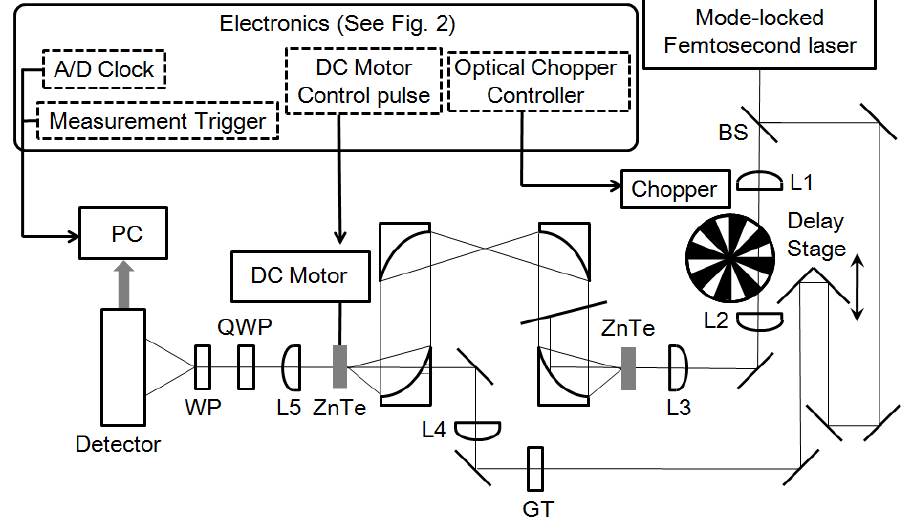
Figure 1. Experimental setup of the measurements of the magnitude and the polarization direction of the terahertz waves with a spinning electro-optic (EO) sensor method with 80-MHz repetition-rate femtosecond laser pulses. Electronic pulse signals used to control the mechanical components and the analog-to-digital converter are also indicated by the words inside the boxes with dotted line borders. The polarization of the probe laser pulse is set parallel to the x -axis which is defined as the direction perpendicular to the propagation direction of the probe laser pulse and parallel to the sheet. The polarization of the pump laser pulse used to generate terahertz waves by optical rectification in the (110)-oriented ZnTe EO crystal is set perpendicular to the x -axis. BS: a beam sampler, L1–L5: optical lenses, Chopper: a mechanical optical chopper, GT: a Glan-Thompson prism, PM1–PM4: parabolic mirrors, QWP: a quarter-wave plate and WP: a Wollaston